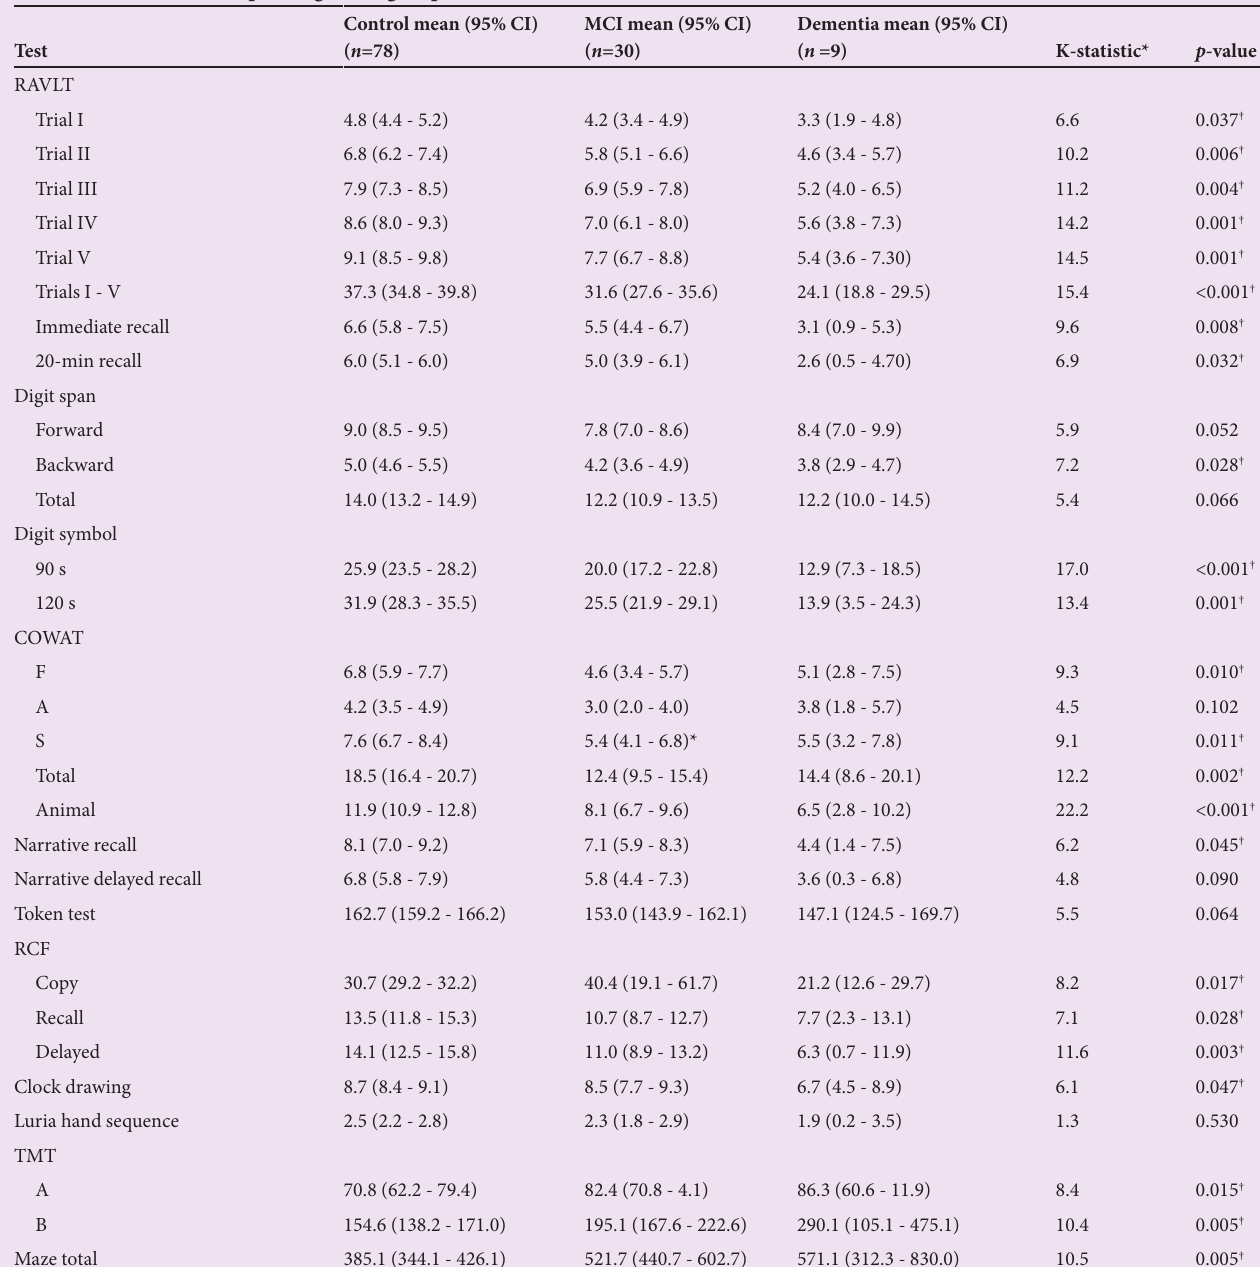
Table 2. Mean test scores per diagnostic groups and